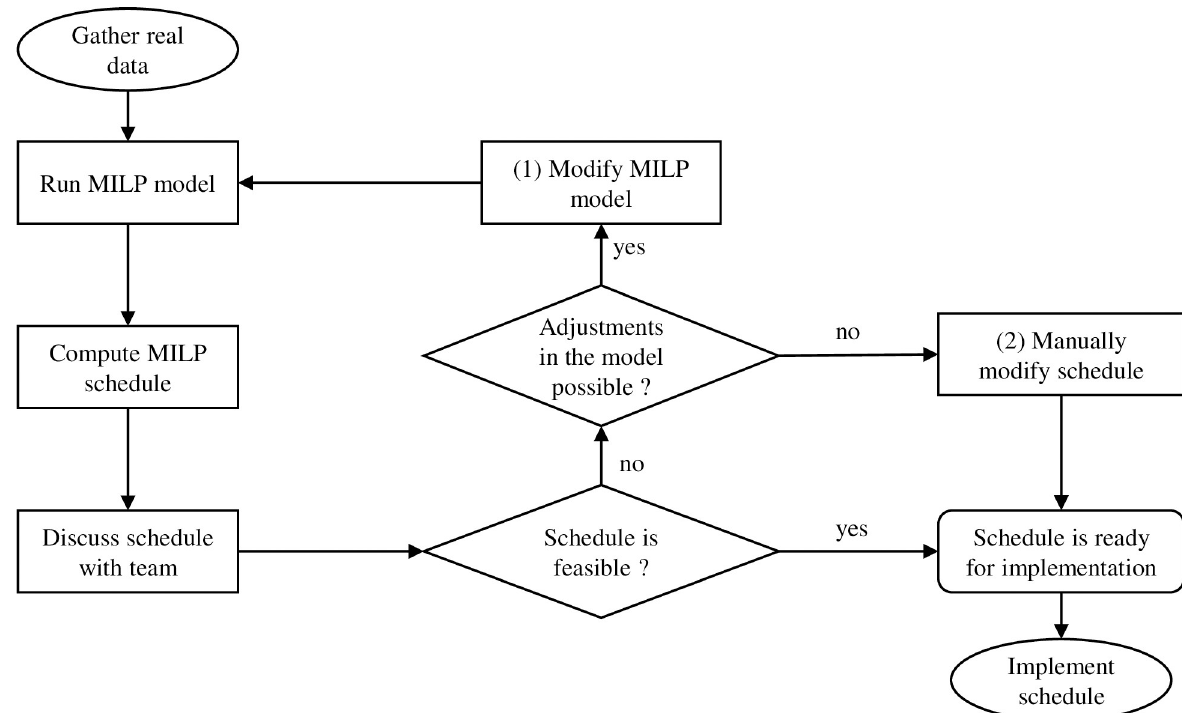
Fig 1. Schematic overview of the MILP-based schedule construction and validation phases before